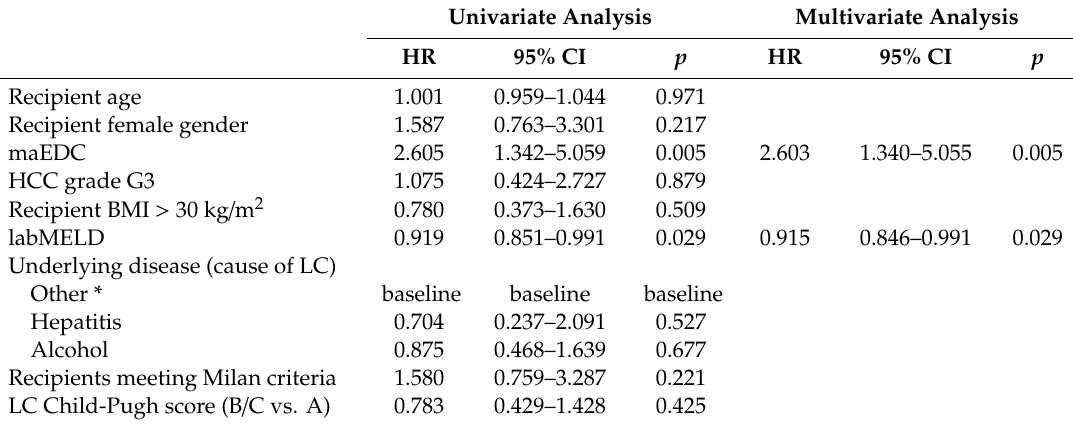
Table 5. Univariate and multivariate cox regression analyses of factors associated with 1-year graft survival.